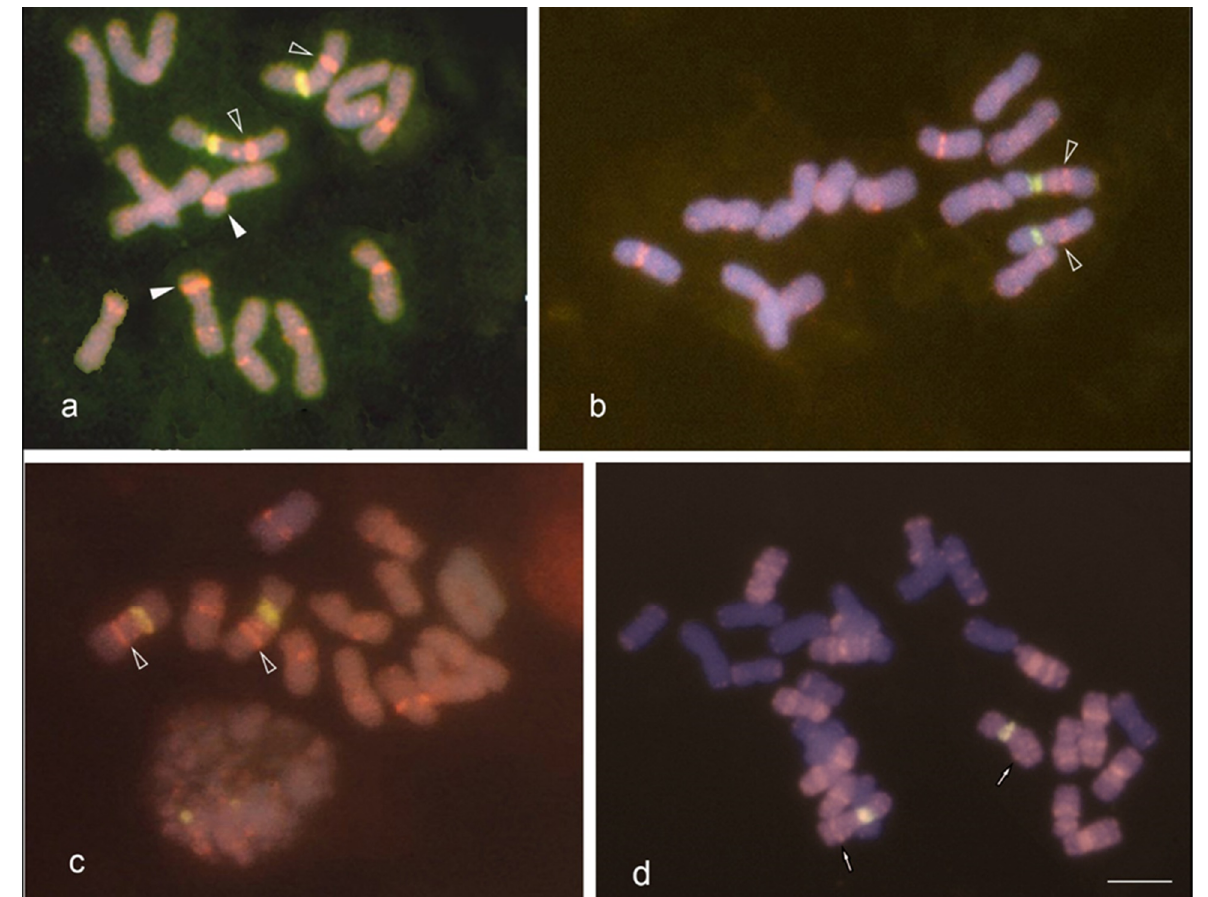
Figure 3. GISH/FISH in the metaphase plates of diploid (2n = 2x = 14) somatic segregants split out from the hexaploid F2 3-18 L. multiflorum × F. arundinacea plant (2n = 6x = 42). ( a – c ) Chromosome sets of diploids N1, N2 and N3 hybridized with L. multiflorum genomic DNA (red) and 45S rDNA probe (green) all show F. pratensis -like chromosomes (mauve) with some interstitial segments of L. multiflorum (red) on rDNA-bearing chromosomes (unfilled arrowheads), and on some other chromosomes (filled arrowheads), two 45S rDNA sites positioned near the centromere are visible in each chromosome set. ( d ) F. pratensis (mauve) subgenome chromosome set representation in F. arundinacea chromosome plate (incomplete), interstitial segments of L. multiflorum (red) on rDNA-bearing chromosomes marked by arrows; F. glaucescens subgenome chromosomes blue (DAPI). Scale bar = 10 µ m. Table 1. Summarized data on the genome composition of the clonal diploid segregants (2n = 2x = 14) from the hexaploid F2 3-18 L. multiflorum × F. arundinacea (2n = 6x = 42) hybrid. Parental Genome/Subgenome Proportion According to GISH Plant Clonal Diploid Plant